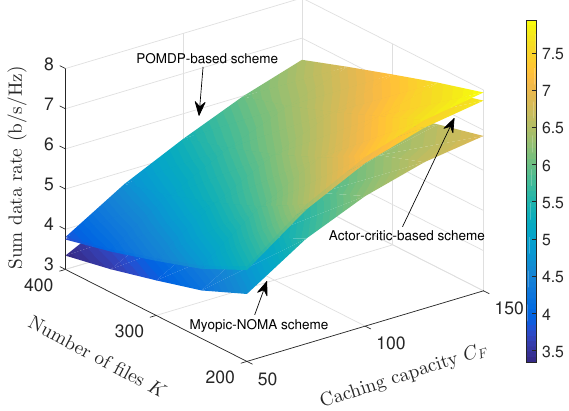
Figure 13. The sum data rate according to different values of K and C F